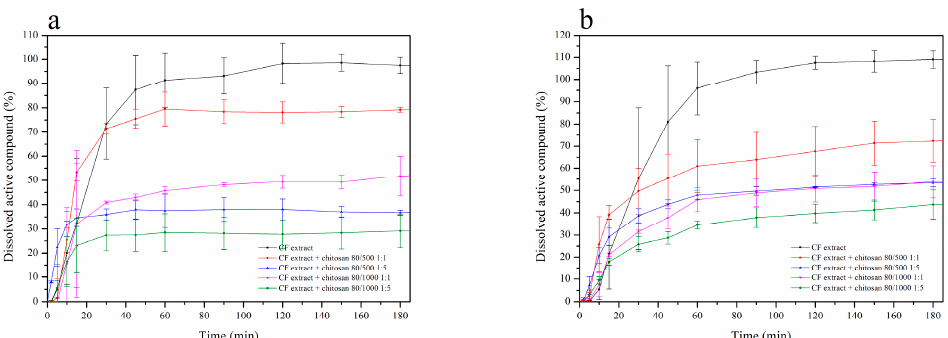
Figure 4. Release profiles of the chlorogenic acid ( a ) and the narcissin ( b ) from the Calendulae flos lyophilized extract and prepared chitosan delivery systems.